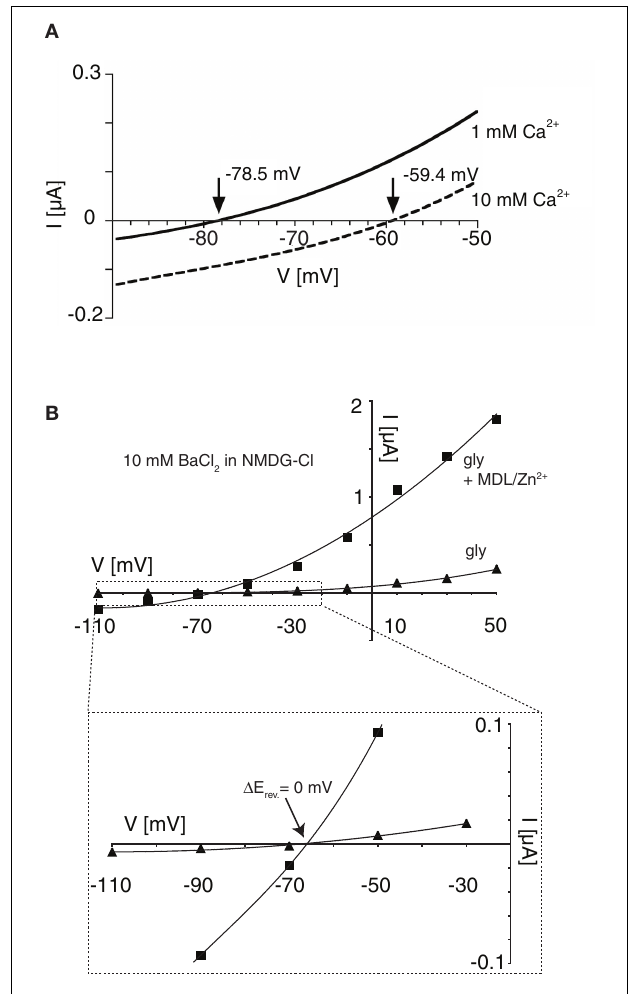
FIGURE 4 | Effect on divalent cation permeability upon supralinear potentiation of glycine-gated NR1/NR3A receptors. (A) Relative divalent to monovalent permeability of NR1/NR3A receptors. Representative I–V recordings around the E obtained in Na + -free ringer containing 1 and 10 mM rev ) of each I–V curve. (B) I–V Ca 2 + . Arrows indicate the reversal potential ( E rev recordings of saturated glycine-induced currents (triangles) versus supralinear potentiated currents with 0.2 µM MDL and 50 µM Zn 2 + (squares) in Na + -free extracellular solution substituted with 115 mM NMDG + and 10 mM divalent cation (Ba 2 + ) present. Enlargement illustrates no changes in the respective reversal potentials ( − 67 mV) for the two